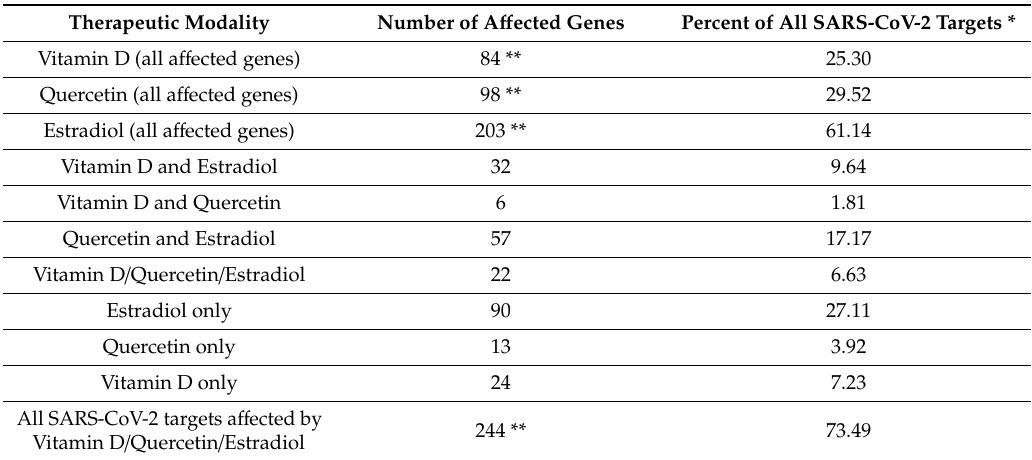
Table 1. Number of drug-specific and common human genes encoding protein targets of SARS-CoV-2, whose expression is altered by vitamin D, quercetin, and